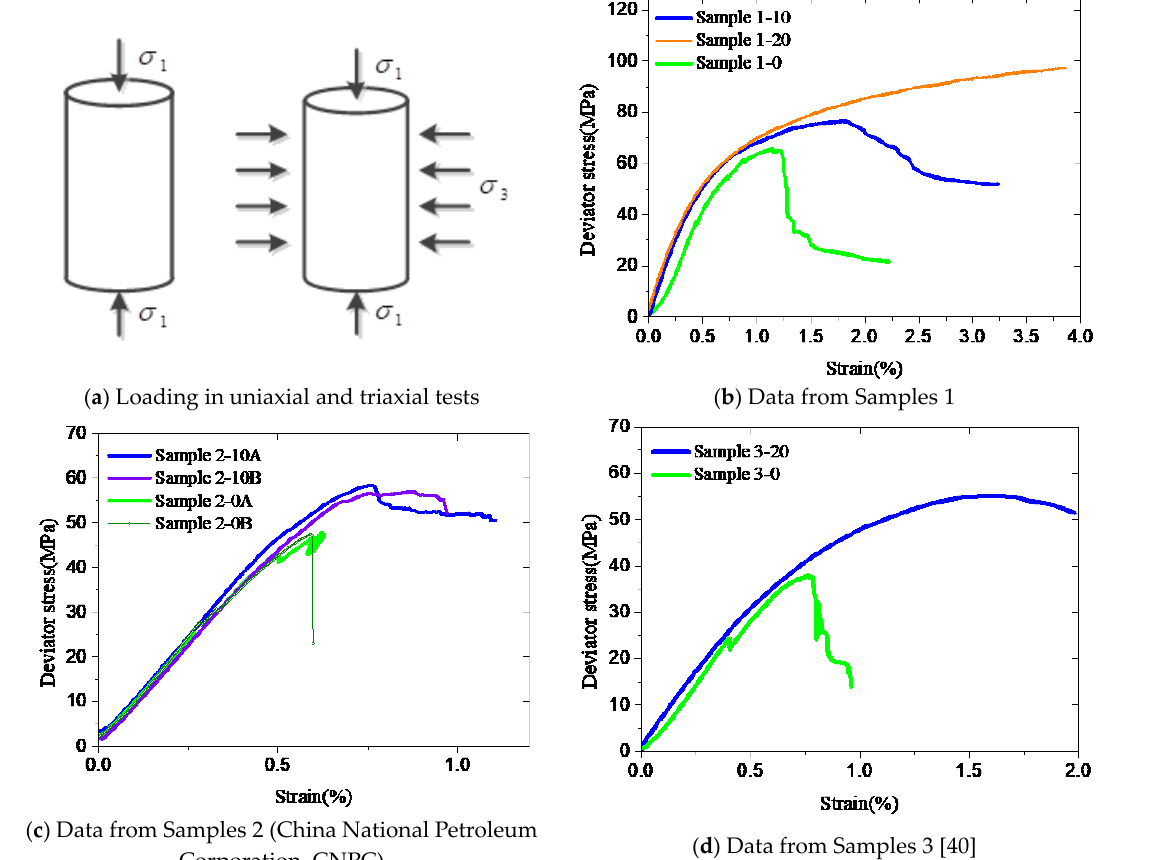
Figure 1. ( a-d ) Experimental results used for calibration of the model.